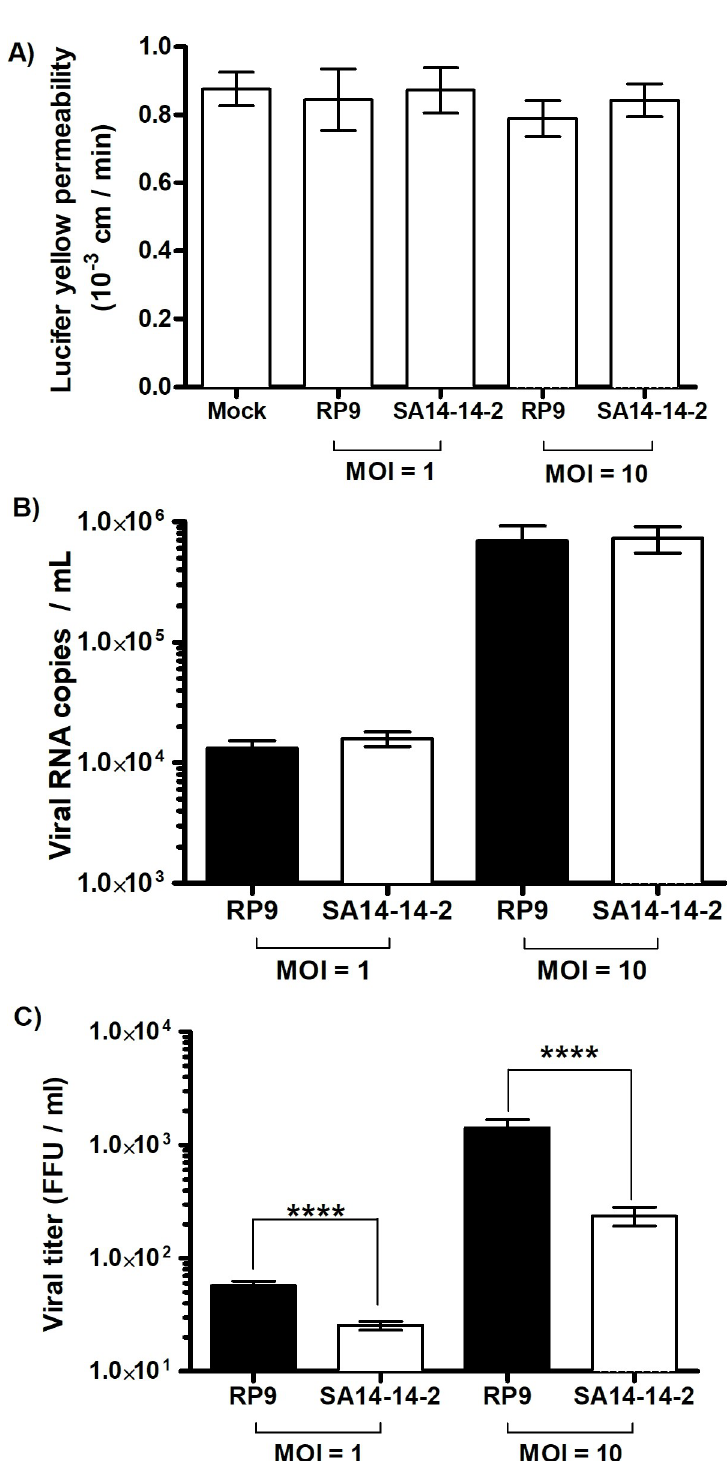
Fig 4. JEV RP9 and JEV SA14-14-2 may cross the in vitro BBB model without disrupting it. A) hCMEC/D3 cells were cultivated on Transwell 1 inserts. Five days after seeding, SK-N-SH cells were added to the wells under the Transwell 1 insert. JEV RP9 or SA-14-14-2 was added to the BBB as indicated 24h later, either at MOI = 1 or = 10. hCMEC/D3 cell permeability to Lucifer Yellow was assayed 6 h post-addition as described in Material and Methods. B) In vitro BBBs were generated as indicated above and either JEV strains were added at MOI = 1 or = 10. After 6 h, total RNA was extracted from media under the inserts and the number of JEV RNA copies was determined by RT-qPCR as